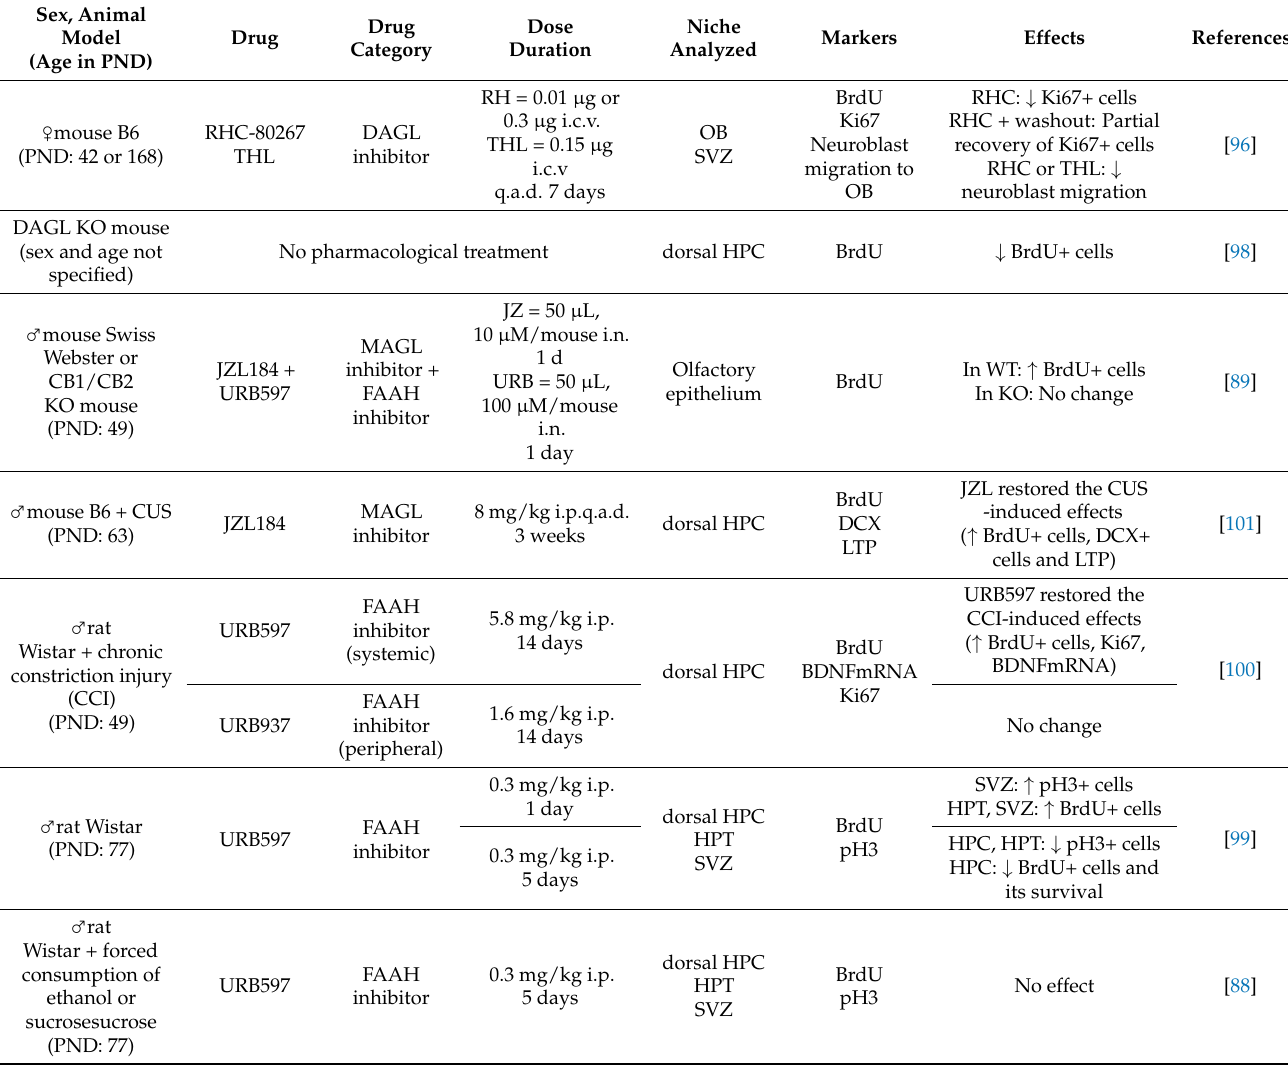
Table 6. Effects of ECS enzyme modulation on